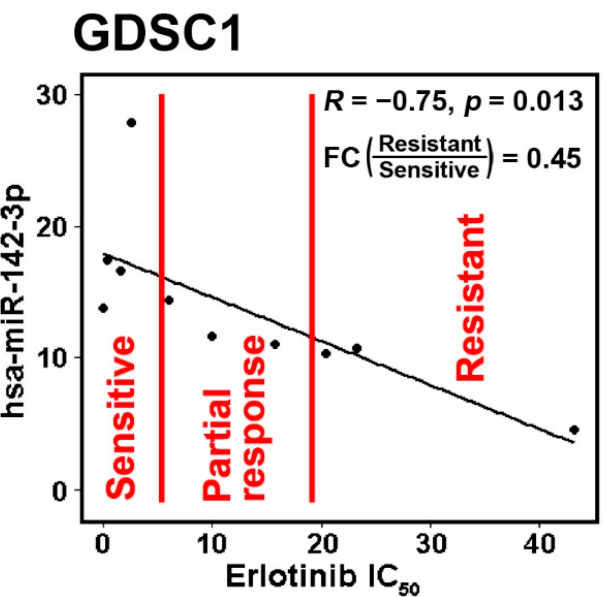
Figure 4. The IC 50 of erlotinib in the dataset Genomics of Drug Sensitivity in Cancer 1 (GDSC1) had significant negative correlation with hsa-miR-142-3p. The NSCLC cell lines were divided with mean ± 0.5 standard deviation (SD) into three groups: sensitive, partial response, and resistant. The sensitive and resistant groups had significantly differential expression with a fold change (FC) = 0.45.